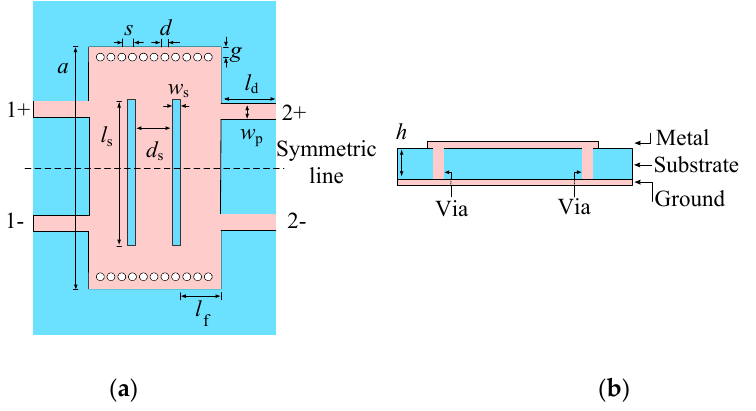
Figure 1. Structure of the proposed balanced SIW phase shifter. ( a ) Top view. ( b ) Cross-sectional view.